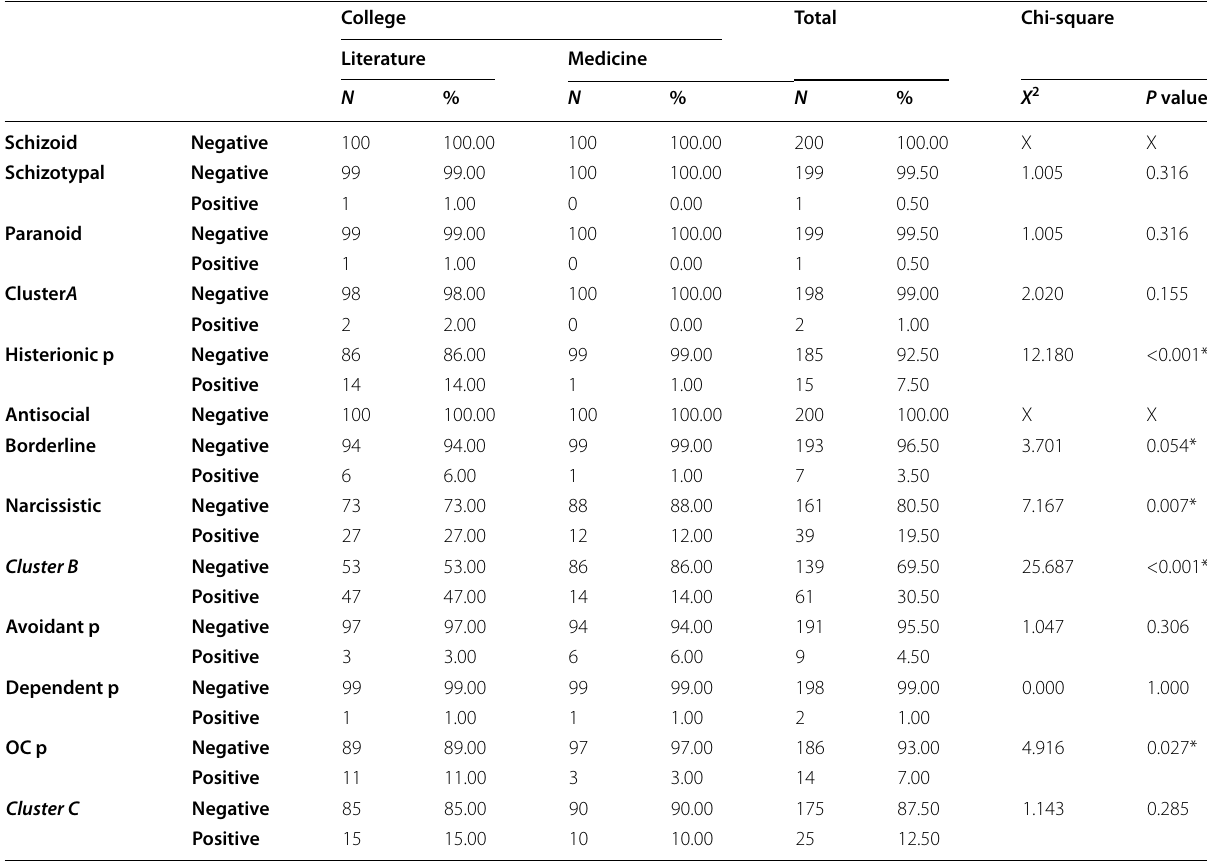
Table 3 Descriptive data for all personality disorders using SCID‑II